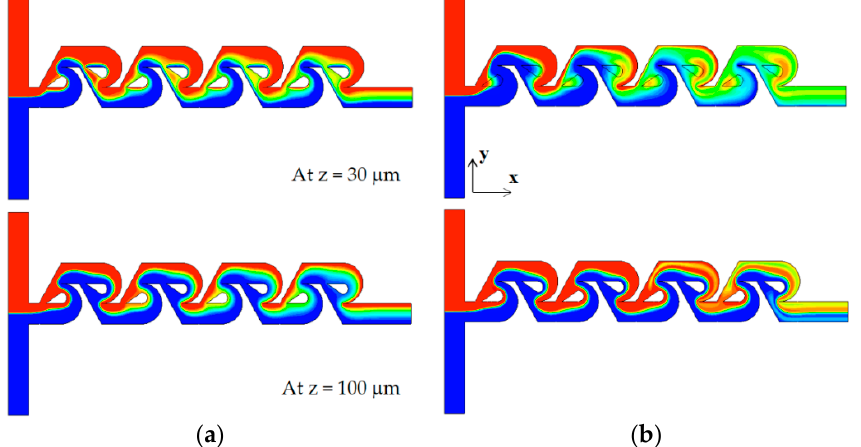
Figure 13. Comparison of concentration contours on the xy planes for Re = 5: ( a ) no clearance and ( b ) with tip clearance h = 60 μ m.